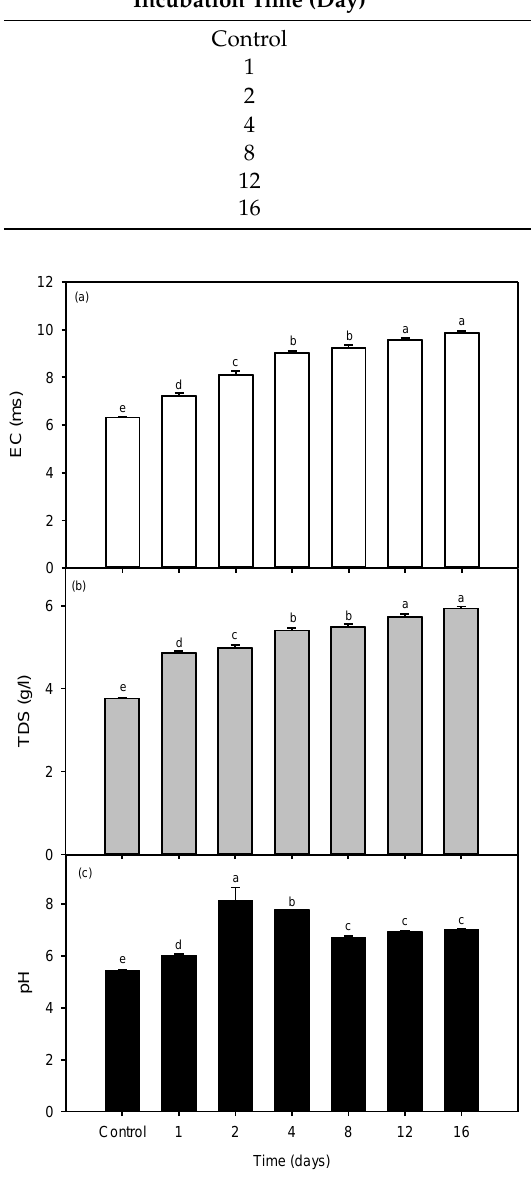
Figure 3. Three parameters measured to assess anaerobic digestion culture conditions, across six incubation time periods (1, 2, 4, 8, 12, and 16 days). ( a ) electrical conductivity (EC), ( b ) total dissolved solids (TDS), and ( c ) pH. Different letters indicate ED, TDS, and pH values that are significantly different ( p < 0.05).